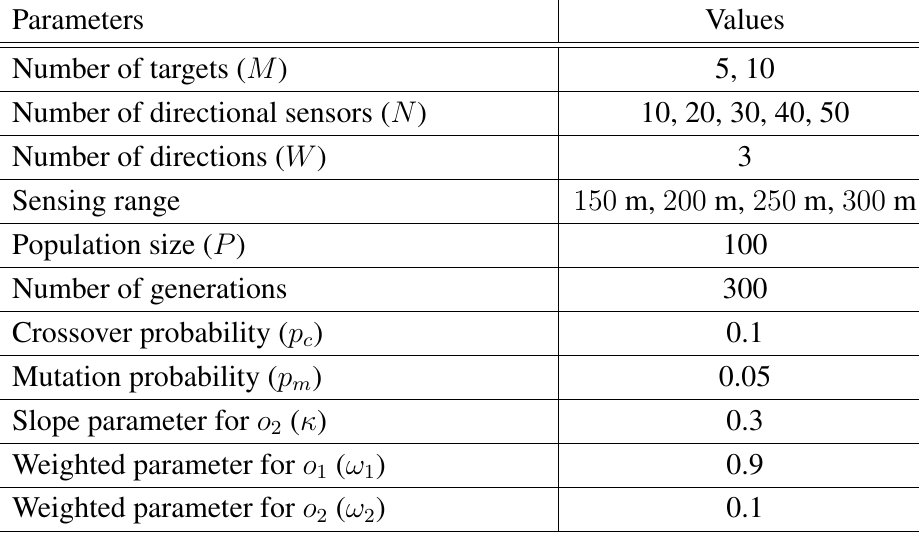
Table 1. Parameters and values used in our